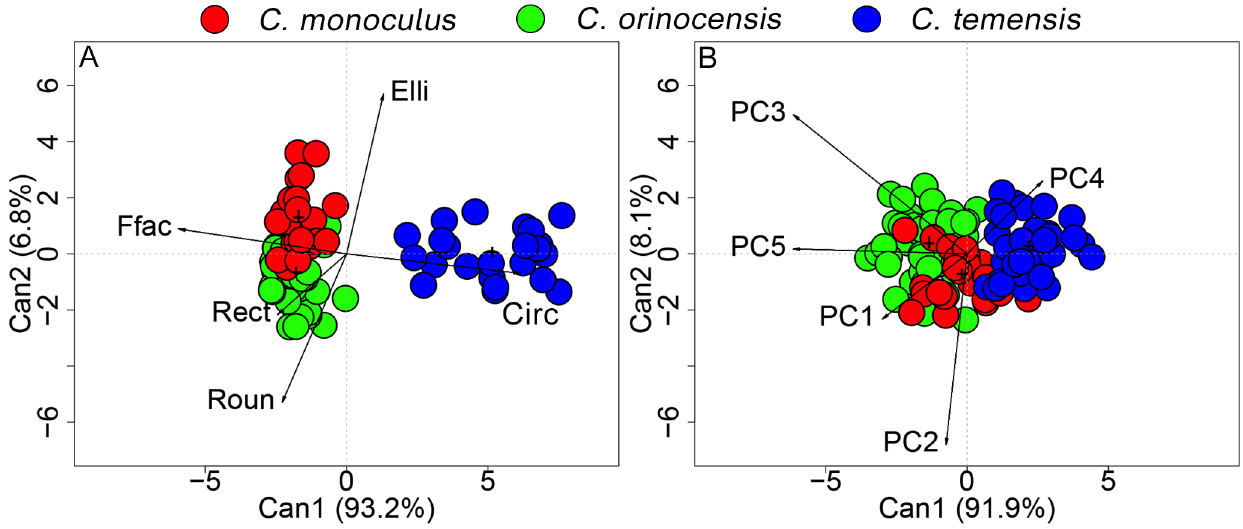
FIGURE 4 | Canonical discriminant analysis based on ( A ) shape indices and ( B ) elliptic Fourier coefficients for the species Cichla temensis , C. monoculus , and C. orinocensis . The vectors indicate the direction and intensity of the influence of the estimated characteristics: Roundness (Roun), Rectangularity (Rect), Ellipticity (Elli), Circularity (Circ), shape factor (Ffac); PC1 to PC5 correspond to the significant scores of the PCA performed on the Fourier